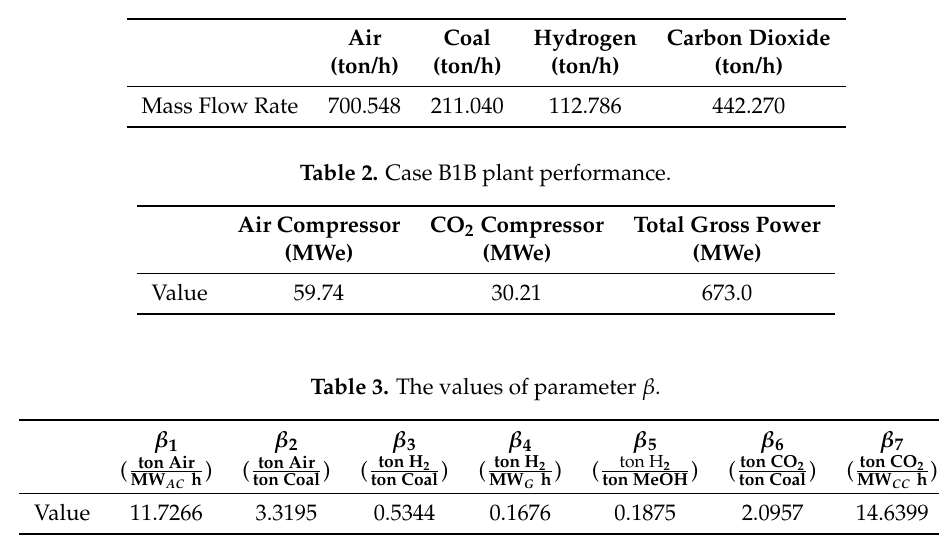
Table 1. Case B1B stream table.